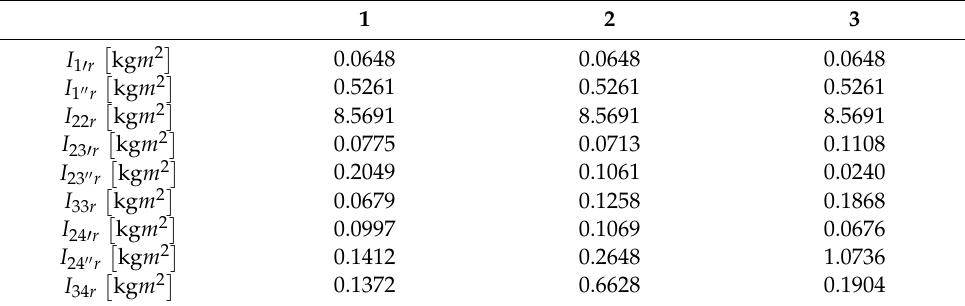
Table 4. Parameters of inertial components.